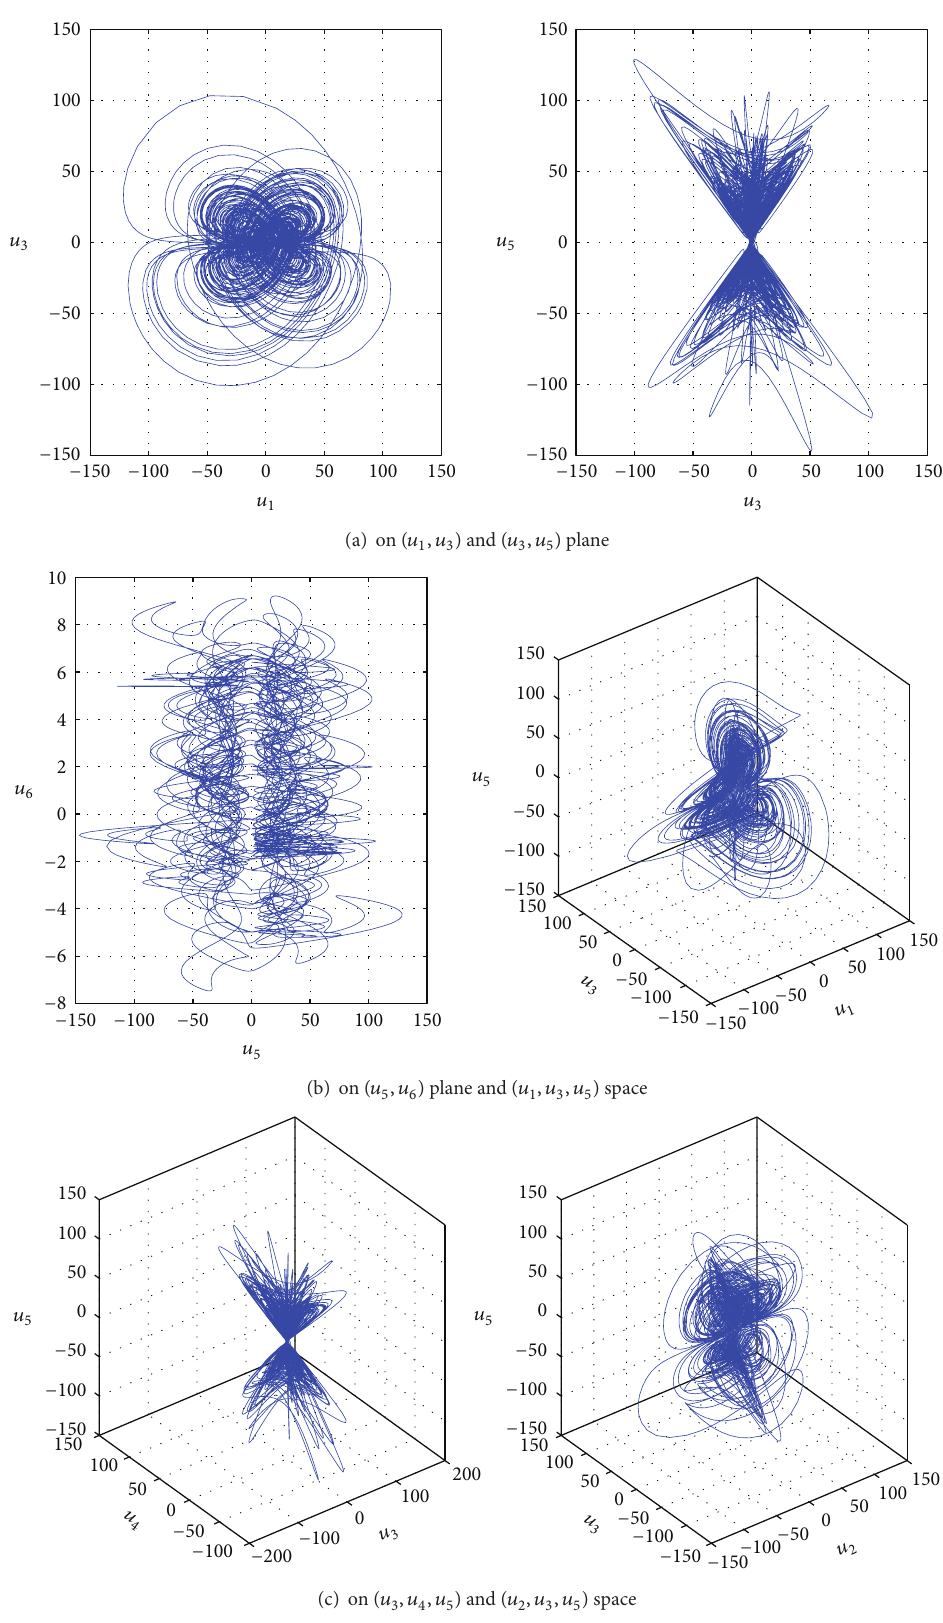
Figure 3: The hyperchaotic attractors of complex Dadras system (5) with 𝑎 = 10 , 𝑏 = 40 , and 𝑐 = 14.9